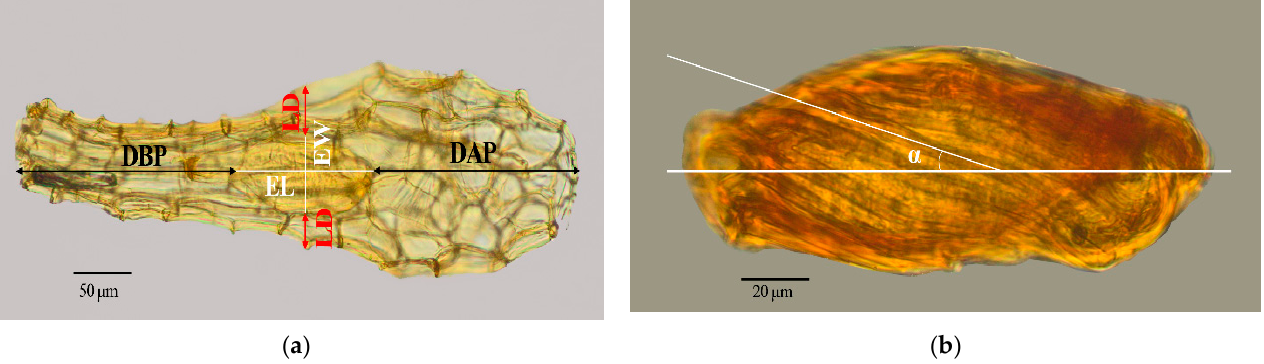
Figure 1. Schemes of the methodology followed under light microscopy to measure the values of ( a ) seed of B. finlaysoniana , distances between seed and embryo (distance to the apical pole, DAP; distance to the basal pole, DBP; lateral distances, LD; embryo length, EL; embryo width, EW); ( b ) seed of B. cecieliae, angle of the medial cells with respect to the longitudinal axis, α .